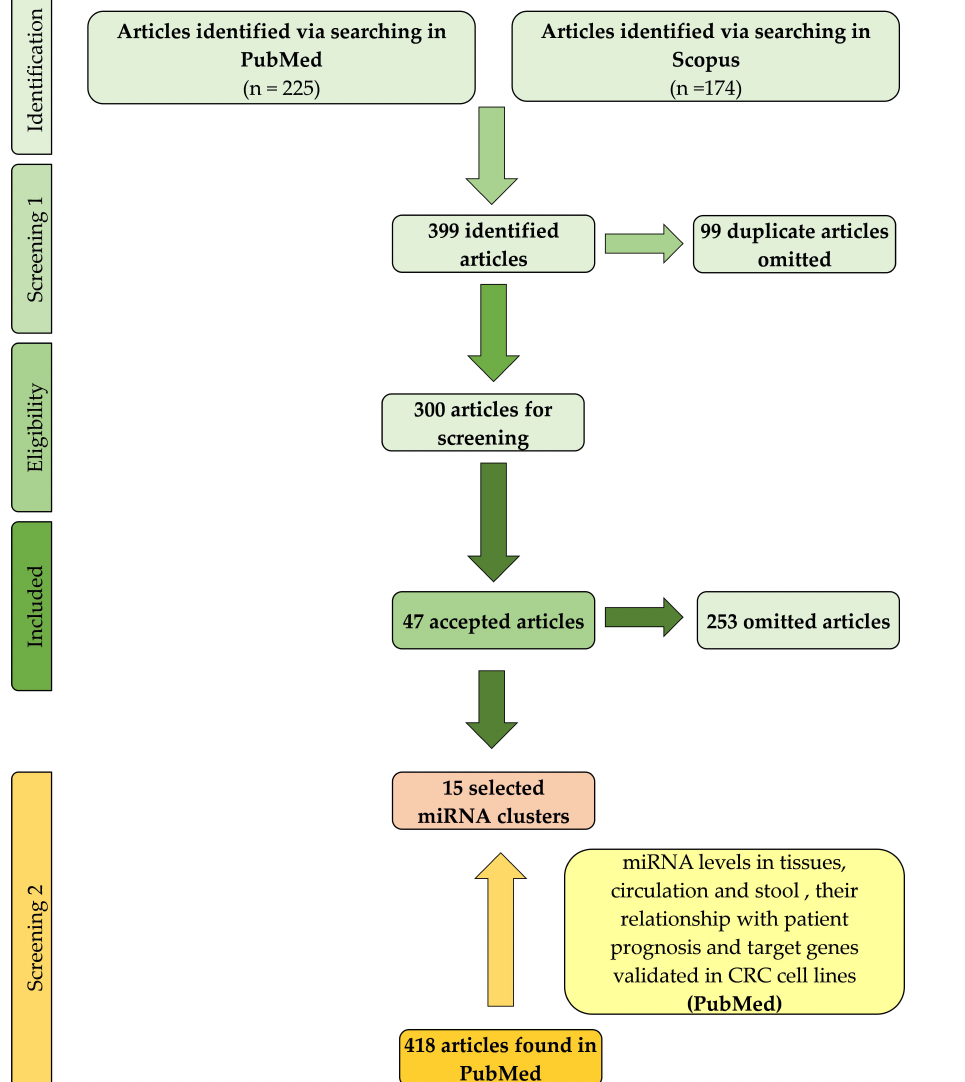
Figure 1. Study flow diagram of selection for up-regulated miRNA